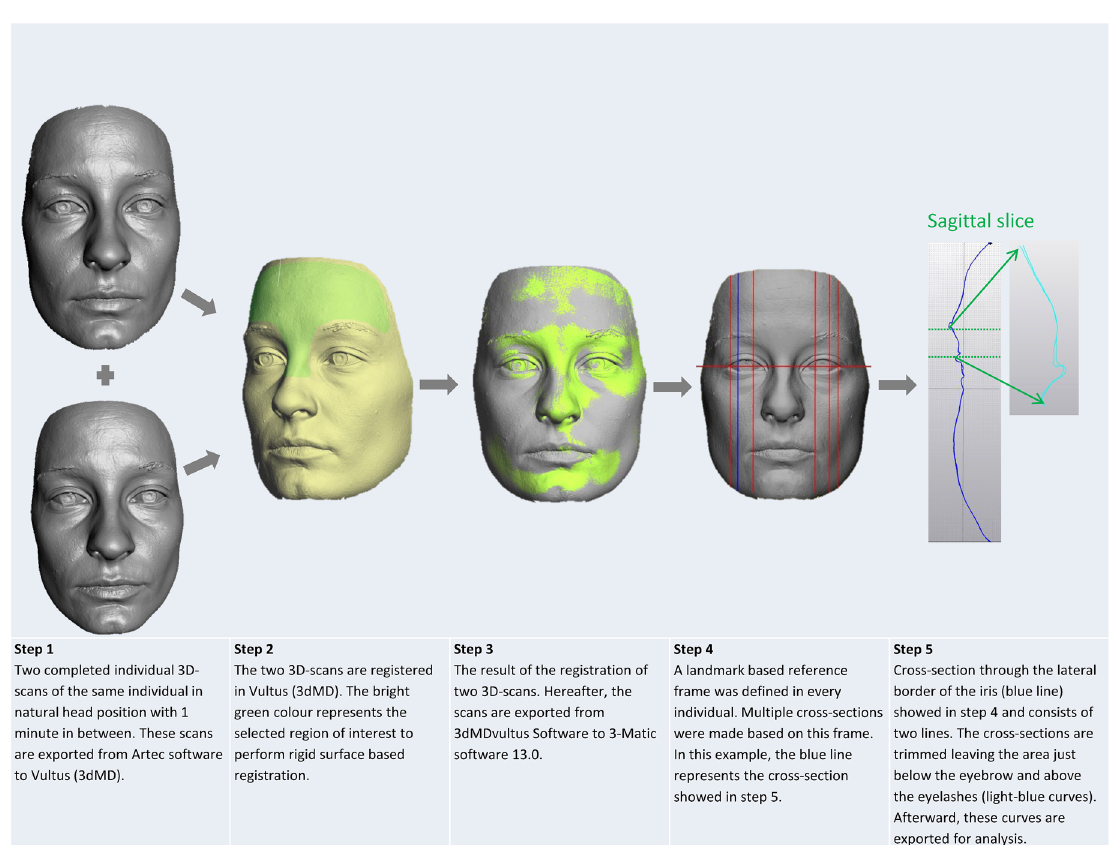
Figure 4. Data processing flowchart. All the depicted data-processing steps are from scanning one volunteer’s natural head position. Used software to create the images in this figure: Artec Studio version 13.0 (Artec, Luxembourg, http://www.artec 3d.com), 3dMDvultus Software version 2.6.0.1 (3dMD LLC, USA, Atlanta, GA, http://www.3dmd.com) and 3-Matic software version 13.0 (Materialise, Leuven, Belgium, http://www.mater ialis